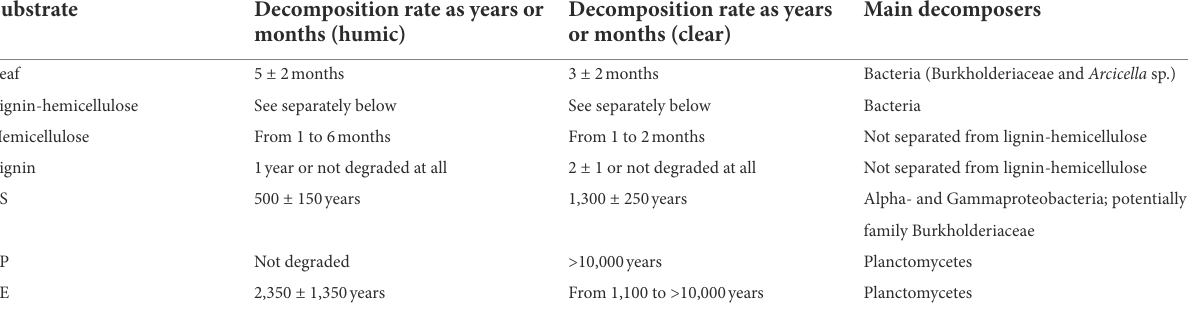
TABLE 1 Decomposition rates and main decomposers of different substrates in humic and clear lake water. Substrate Decomposition rate as years or Decomposition rate as years Main decomposers months (humic) or months (clear) 5 ± 2 months 3 ± 2 months Bacteria (Burkholderiaceae and Arcicella